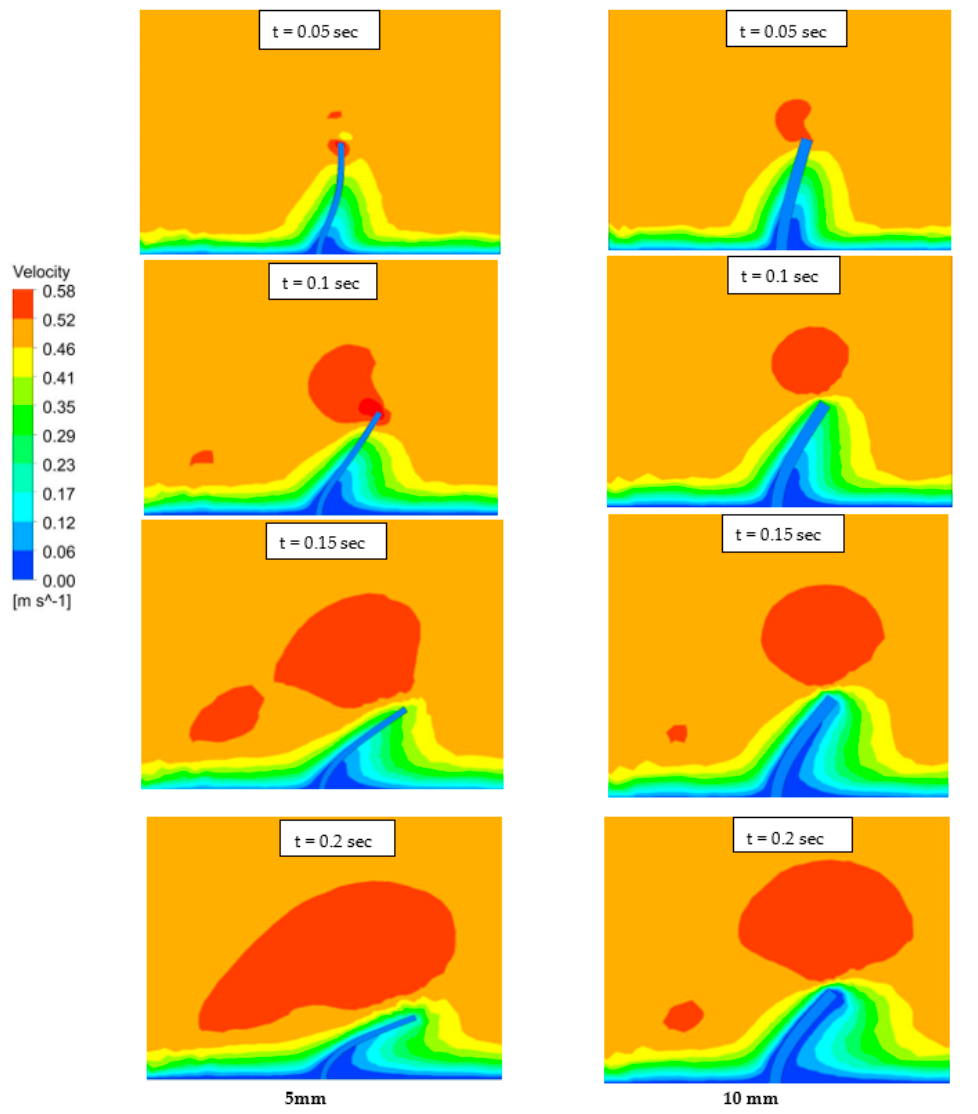
Figure 12. Flap movement of different thicknesses at various time steps.